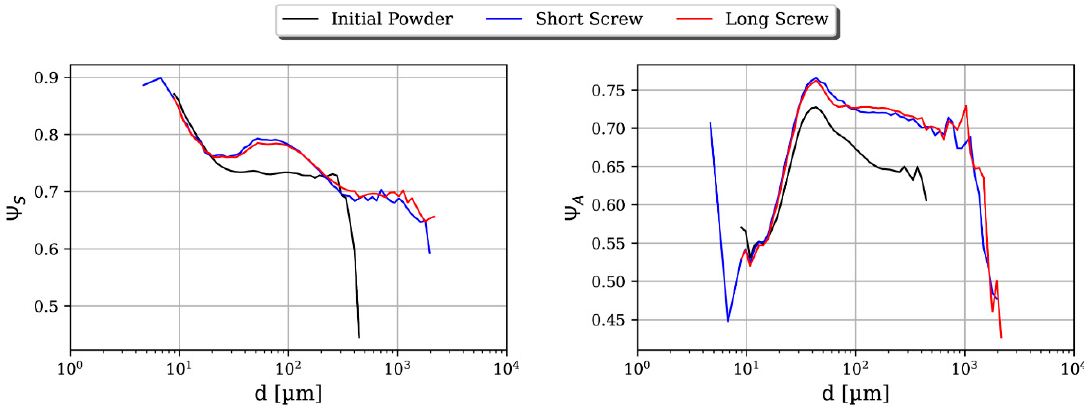
Figure 5. Sphericity and aspect ratio distributions over particle size for low L/S and low SFL for the initial powder, the short screw, and the long screw configuration.